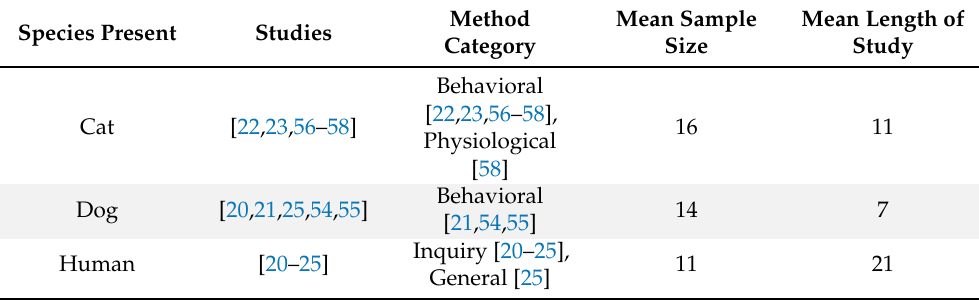
Table 4. Species and measurements break down for companion animals. The mean study length column represents the average time (in days) of study procedures. Shading added to aid readability. Species Present